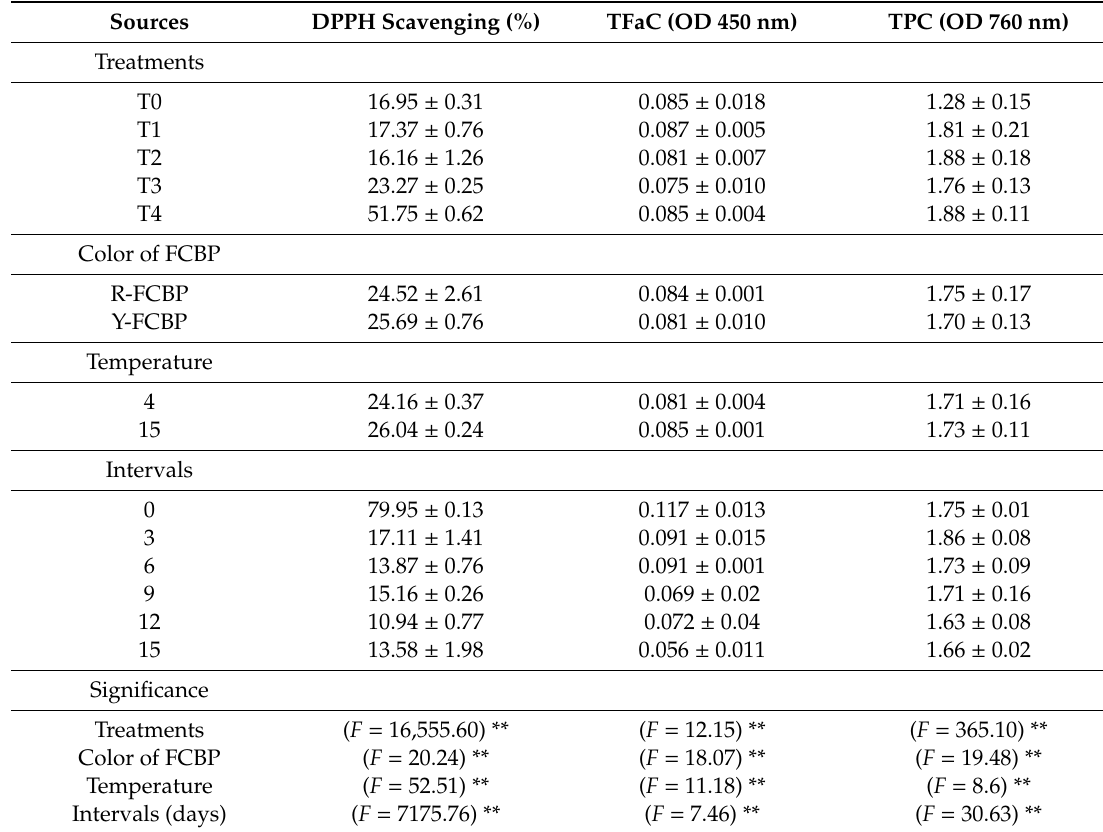
Table 2. Analysis of antioxidant and phytochemical changes in fresh-cut bell pepper (FCBP) treated or untreated with Lactobacillus rhamnosus GG and biochemical agents at di ff erent time intervals (days) and preserved in two di ff erent temperatures (4 and 15 ◦ C). The results presented the estimated